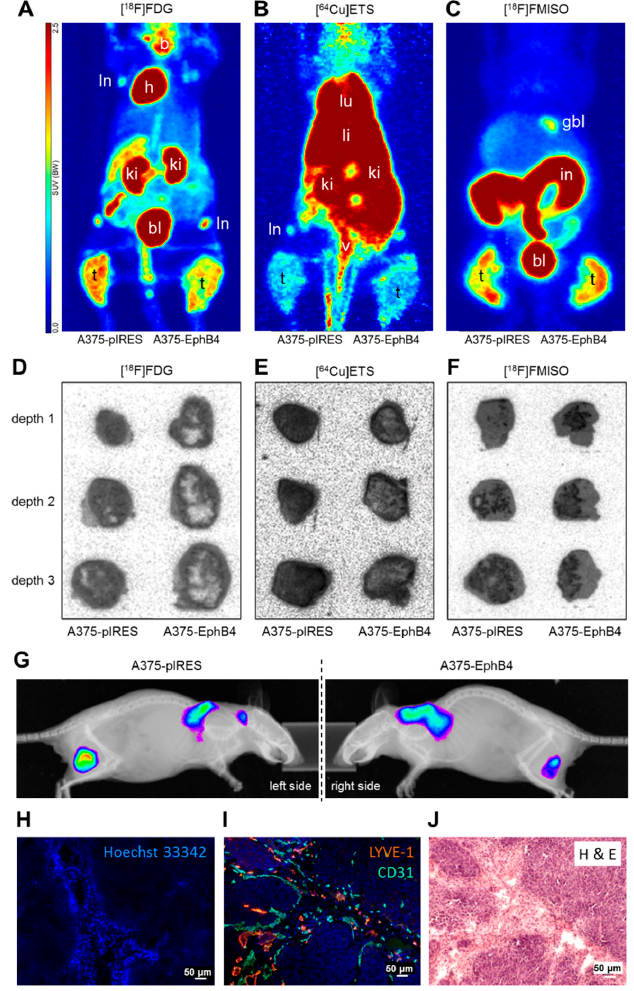
Figure 3. Representative images of PET, radioluminography, in vivo fluorescence imaging, and ex